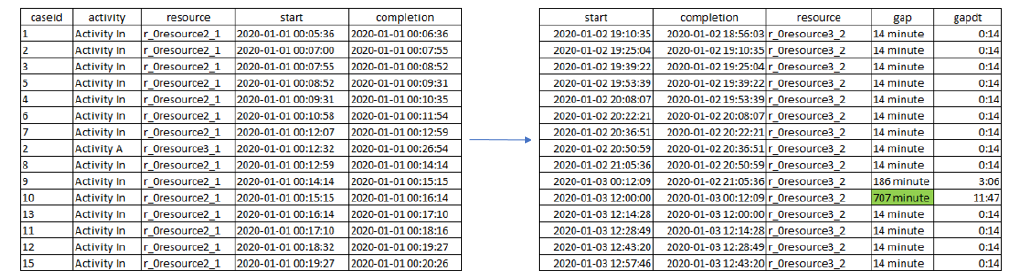
Figure 8. Preprocessing the event logs of our resource mining